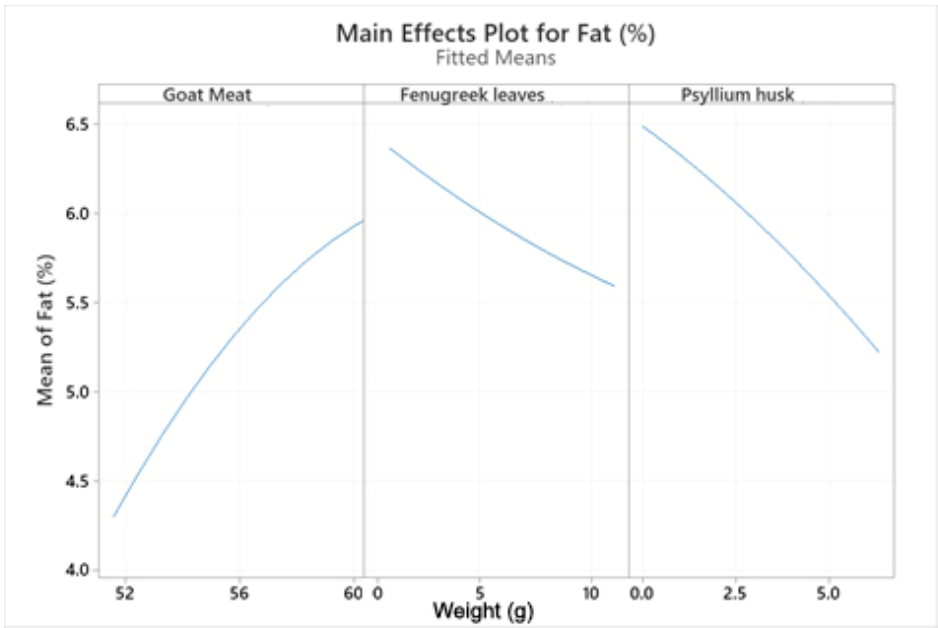
Figure 3. Individual main effects plot for fat (%).